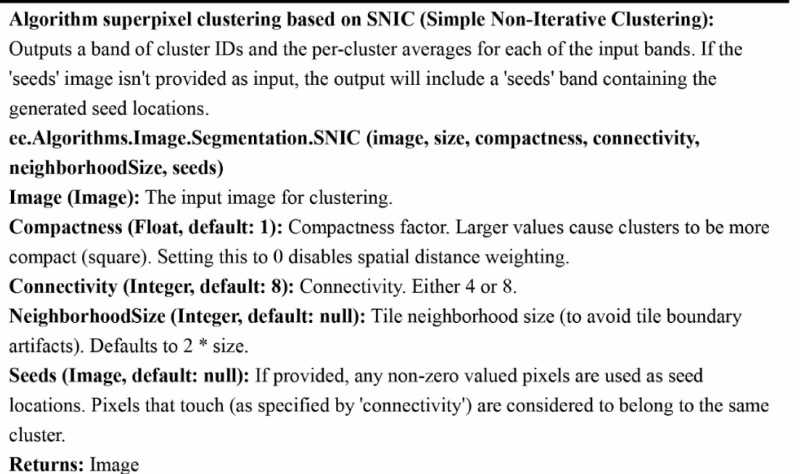
Figure 5. SNIC parameter description.